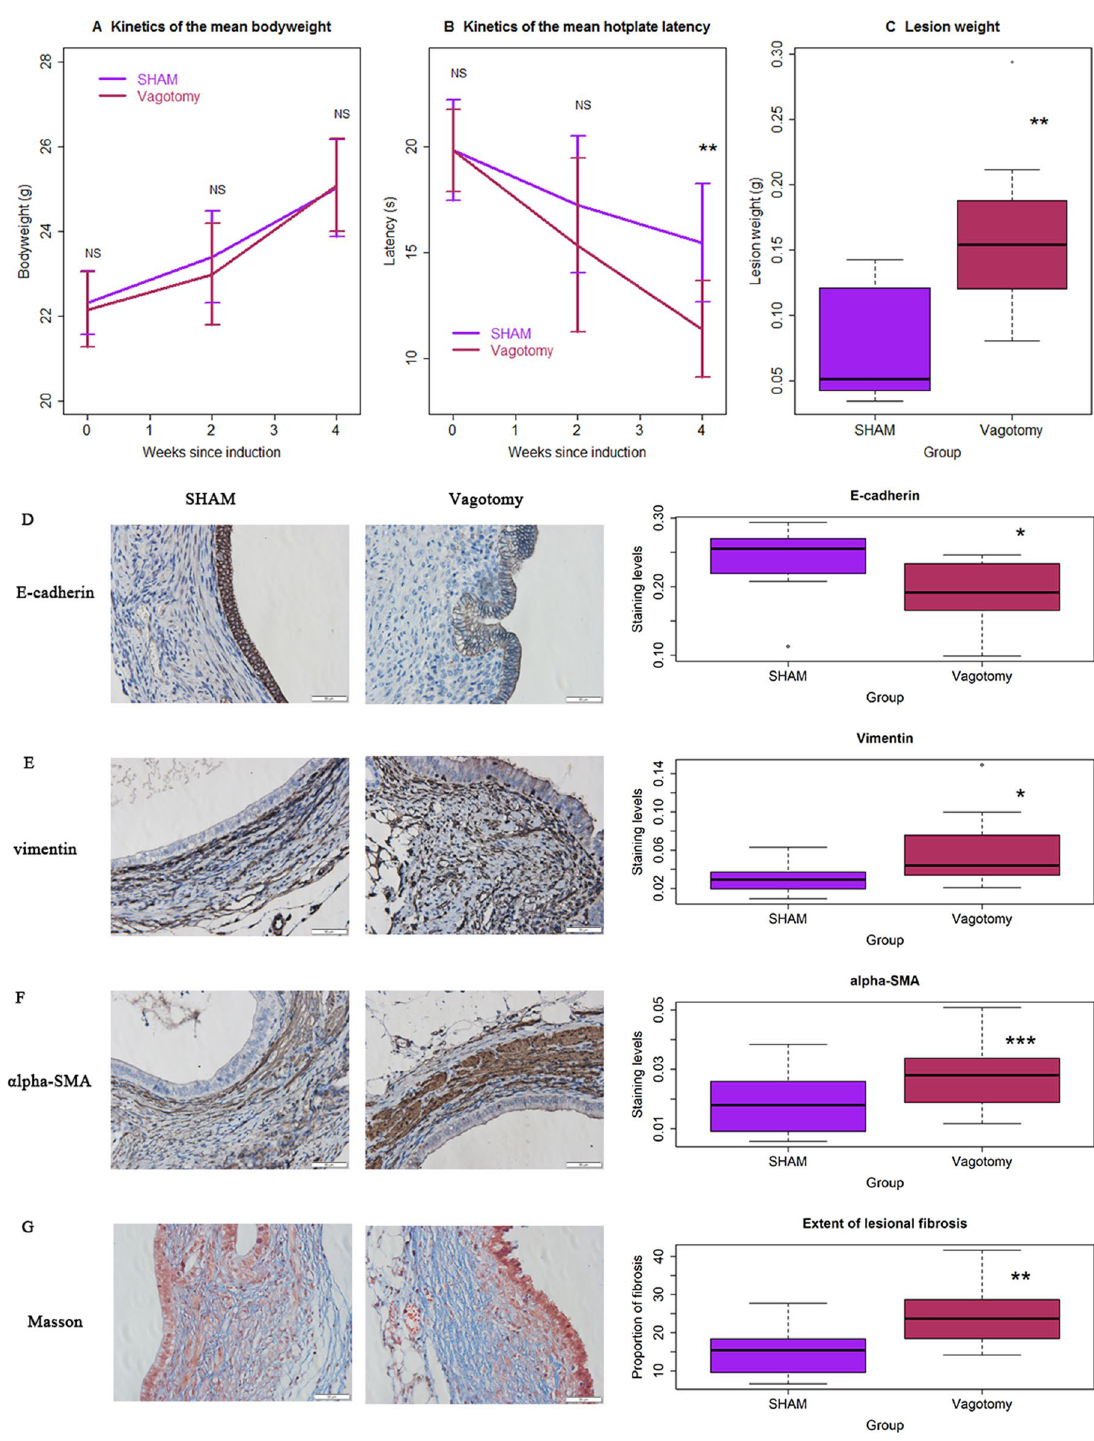
Figure 2. Vagotomy accelerates the development of endometriosis in mouse. ( A ) Kinetics of the mean bodyweight in the vagotomy and the control groups. No significance was found between two groups at any time point evaluated. ( B ) Kinetics of the average hotplate latency, tested at the indicated times in the two groups. Statistically significant difference in latency between the two groups is found at the end of the experiment, 2 weeks after the induction of endometriosis. ( C ) Boxplot of the lesion weight between mice with vagotomy and without. Representative immunostaining results for E-cadherin ( D ), vimentin ( E ) and α-SMA ( F ) in ectopic lesions from the two groups of mice (left panel), along the boxplot summarizing the immunostaining data (right panel). ( G ) Representative images of Masson trichrome staining in endometriotic lesions in vagotomy and control groups (left panel), along with the boxplot summarizing the results (right panel). The smooth muscle cells are stained in red and collagen fibers in blue. n = 10 in each group. The asterisk indicates the statistical significance level, calculated based on multiple linear regression analyses: NS: p > 0.05; * p < 0.05; ** p < 0.01; *** p < 0.001. In all regressions, R 2 ≧